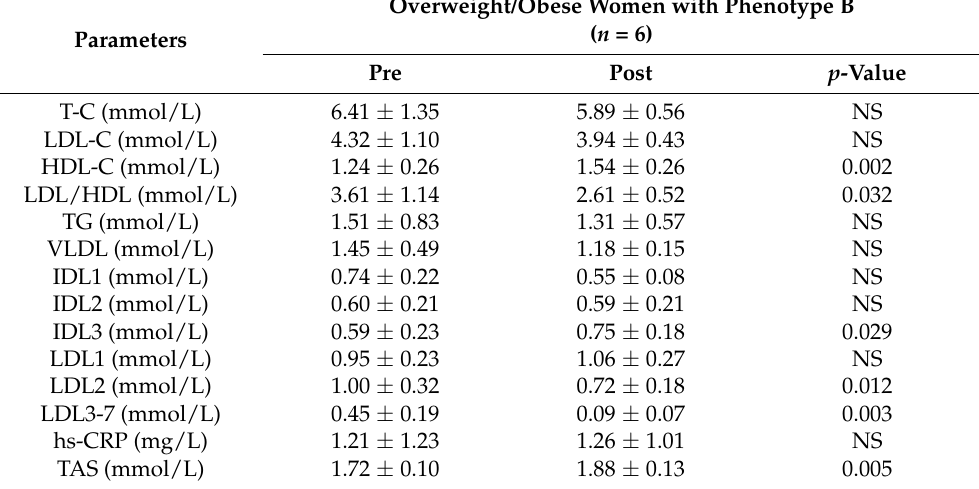
Table 5. Lipid profile, lipoprotein subfractions, and inflammatory biomarkers (hs-CRP) before (pre) and after (post) 6 weeks of the apple/berry intervention in overweight/obese women with atherogenic phenotype B (presence of LDL3-7